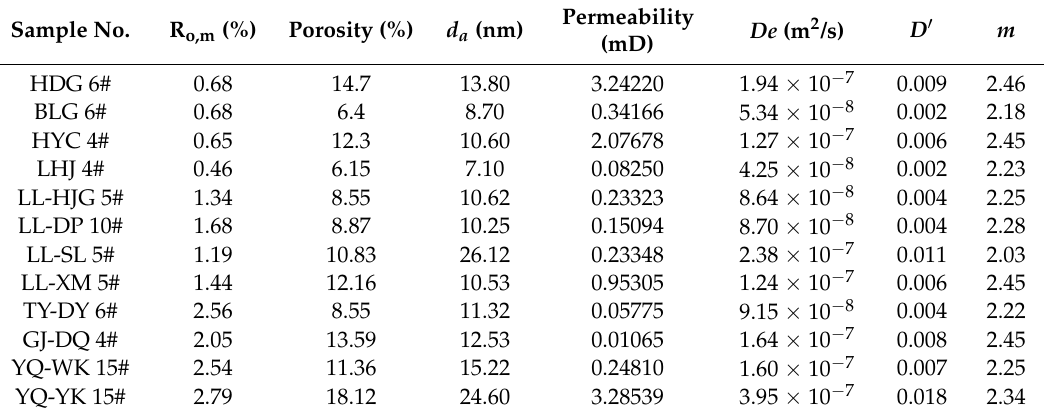
Table 2. Porosity, permeability, effective diffusion coefficient and m values by MIP.